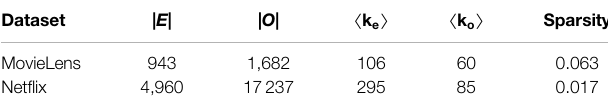
TABLE1| Basicstatisticalpropertiesoftherealdatasetsusedinthispaper,where 〈 k 〉 and 〈 k 〉 are the average degree of evaluators and objects. u o